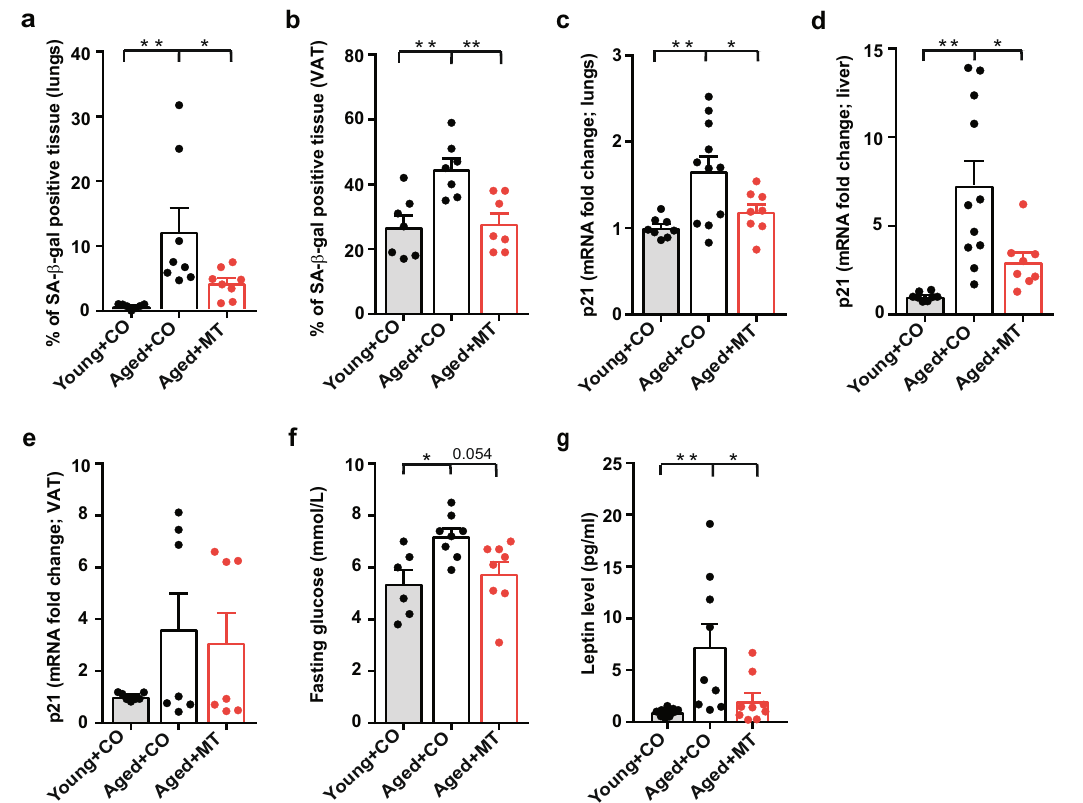
Fig. 1 MitoTam improves metabolic parameters in naturally aged mice. C57BL/6 mice 2 (young) and 18 months of age (aged) were treated i.p. once per week for a period of 4 weeks with MitoTam (2 mg/kg body weight; MT) dissolved in 4% EtOH in corn oil or with the vehicle (CO). a , b Lungs ( a ; young n = 8, aged n = 10, aged + MT n = 8; young vs. aged p = 0.005, aged vs. aged + MT p = 0.049) and VAT ( b ; n = 7; young vs. aged p = 0.004, aged vs. aged + MT p = 0.006) were excised and assessed for SA- β -gal activity, which was expressed as % of SA- β -gal-positive tissue. c – e Expression of p21 waf1 mRNA in lungs ( c ; young vs. aged p = 0.005, aged vs. aged + MT p = 0.048), liver ( d ; young vs. aged p = 0.001, aged vs. aged + MT p = 0.035; c , d young n = 8, aged n = 11, aged + MT n = 8) and VAT ( e ; n = 7) was estimated by qRT-PCR. f Fasting glucose level in young ( n = 6), aged ( n = 8) and aged mice treated with MitoTam ( n = 8) was assessed after 16 h of fasting (young vs. aged p = 0.021, aged vs. aged + MT p = 0.054). g Level of leptin in plasma was estimated ( n = 9; young vs. aged p = 0.007, aged vs. aged + MT p = 0.026). For all panels, a – g one-way ANOVA, Tukey´s comparison multiple test was used. Data are expressed as mean ± SEM; * p < 0.033; ** p < 0.002; *** p < 0.001. Source data are provided as a Source Data fi